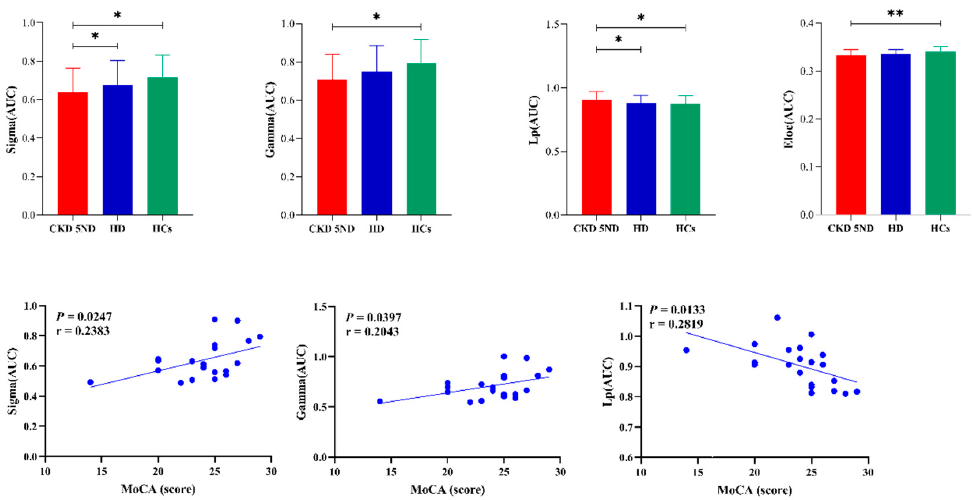
Figure 3. Comparisons of AUC values (thresholds ranged from 0.05 to 0.50) in small-world metrics (Sigma, Gamma, Lp) and Network Efficiency (Eloc) between the CKD5 ND, HD, and HC groups. (* p < 0.05; ** p < 0.01). AUC, the area under the curve; Sigma, small-worldness; Gamma, normalized clustering coe ffi cient; Lp, characteristic path length; Eloc local e ffi ciency.